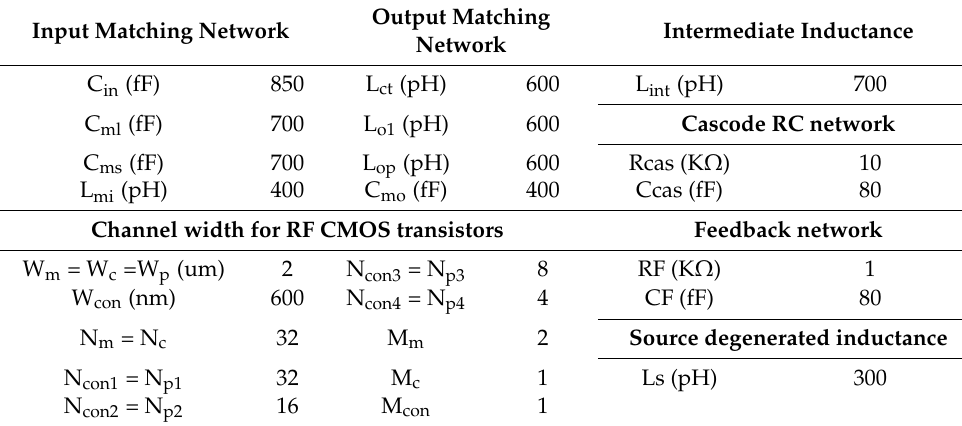
Table 3. Initial design parameter values for the